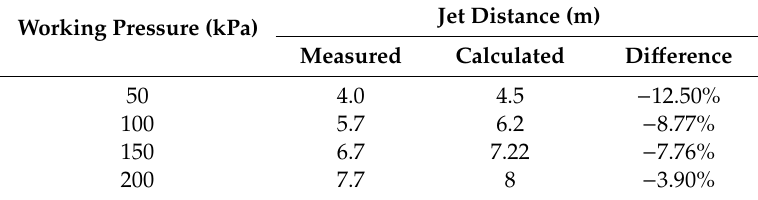
Table 4. Comparison of measured and calculated jet distances for di ff erent working